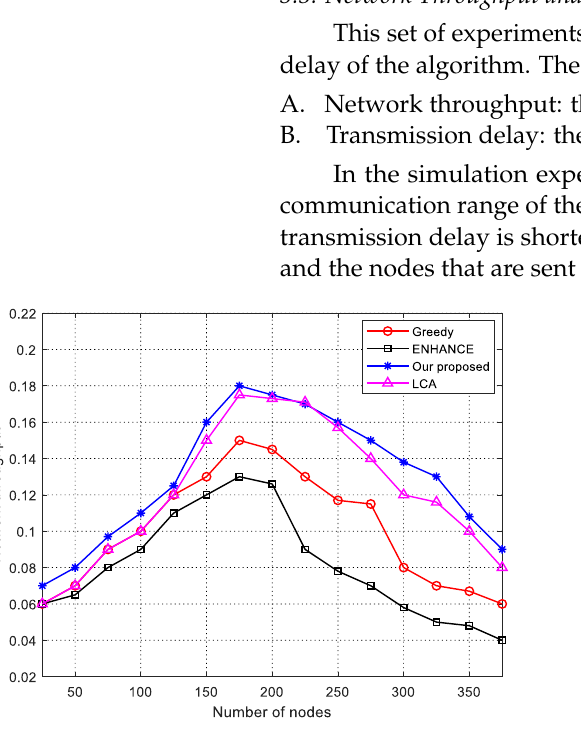
Figure 12. Effects of different 𝑇 0 on signal conflict.